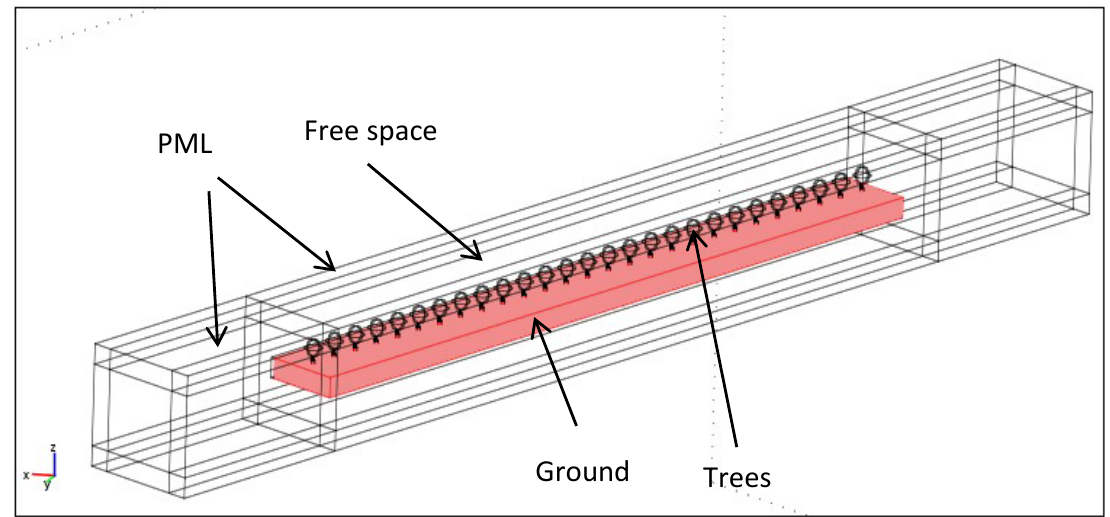
Figure 4. Row of cherry trees and soil slab embedded in a bounding